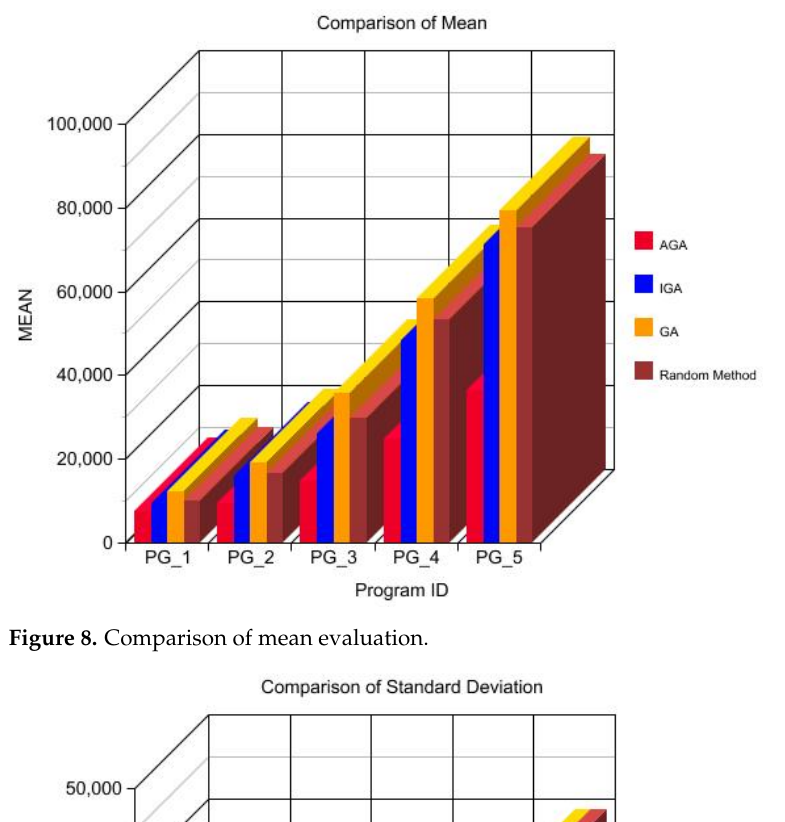
Figure 8. Comparison of mean evaluation.